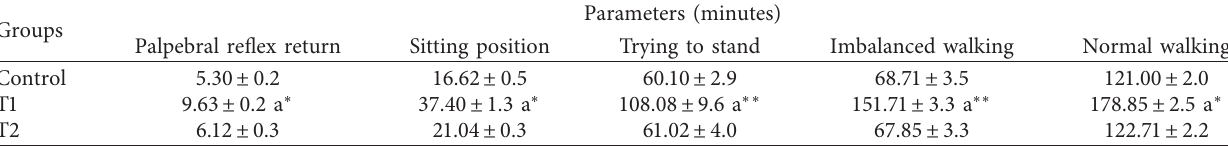
Table 3: Comparison of recovery time in studied groups following anesthesia induced by sodium thiopental.